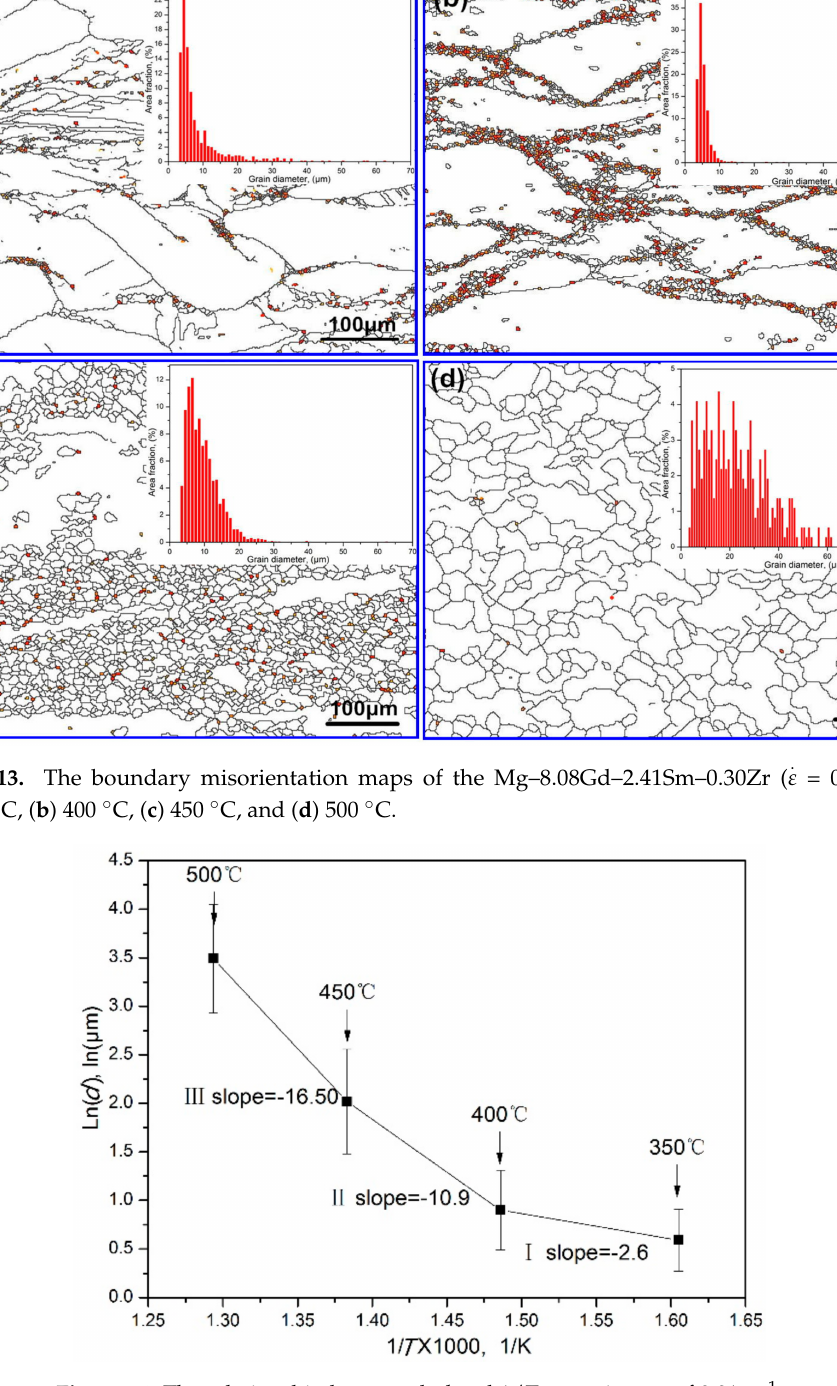
Figure 14. The relationship between ln d and 1/ T at strain rate of 0.01 s − 1 . Surprisingly, the ln d –1/ T curves measured at 0.01 s − 1 do not show any linear